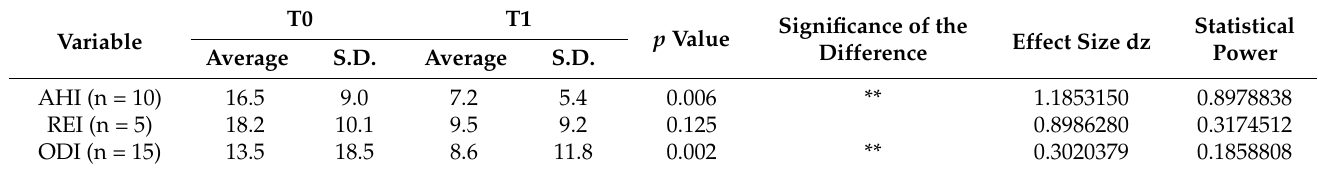
Table 5. Changes in AHI, REI, and ODI values before and after using the MAD.